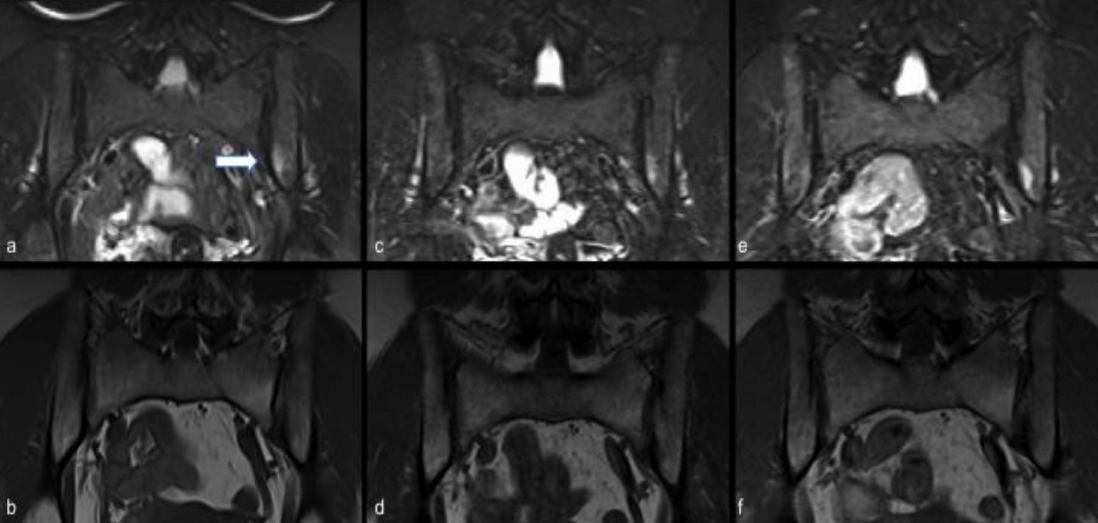
Figure 2. Case report 2. Persistent MRI findings of unilateral active sacroiliitis in a 53-year-old woman with lower back pain. At the time of first MRI examination, subchondral bone marrow oedema at the iliac side of the left sacroiliac joint was observed, appearing as band-like hyperintensity on short-tau-inversion recovery STIR T2-weighted semi-coronal image (arrow in ( a )) with corresponding hypointensity on turbo-spin-echo TSE T1-weighted semi-coronal image ( b ). Oedema was found to persist at subsequent MRI examinations performed after one month ( c , d ) and six months ( e , f